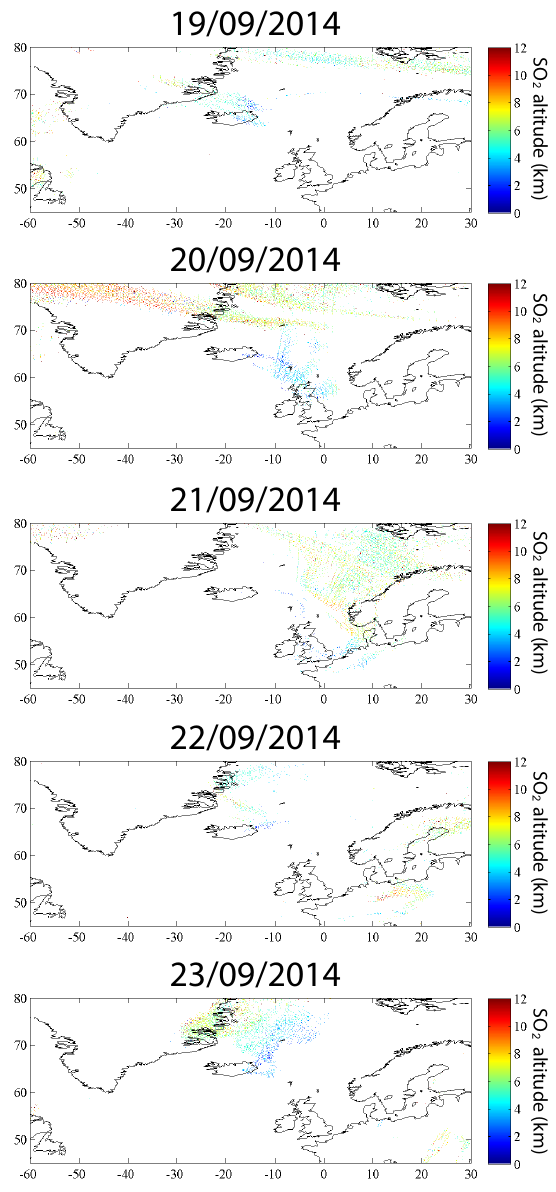
Figure 1. Altitude (in kilometres a.s.l.) of Bárðarbunga SO 2 re- trieved from IASI